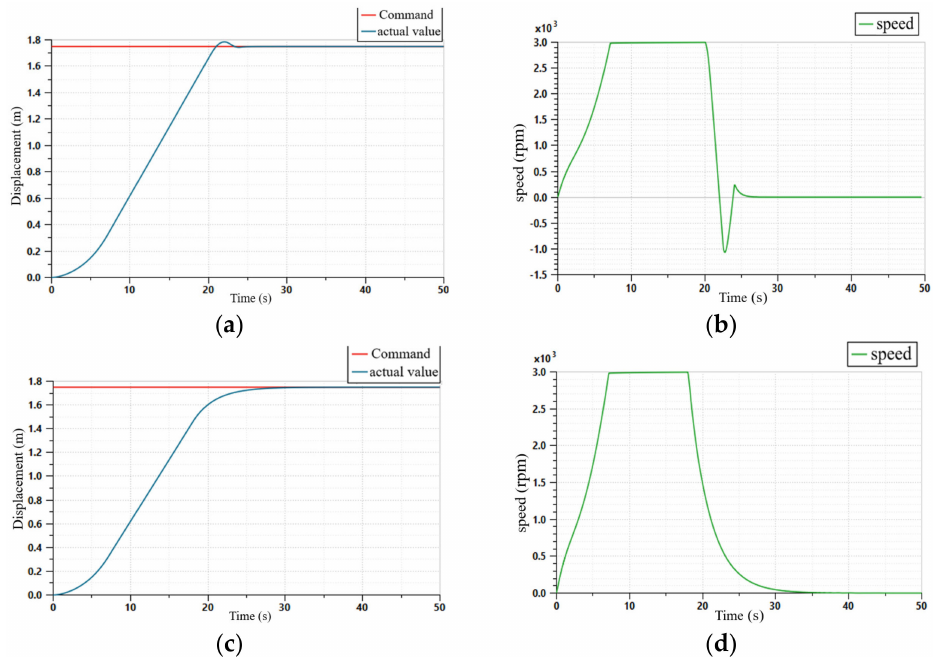
Figure 13. Simulation results of the control algorithm under the influence of impact lateral force: ( a ) erecting displacement of PID; ( b ) motor speed of PID; ( c ) erecting displacement of ARDC; ( d ) motor speed of